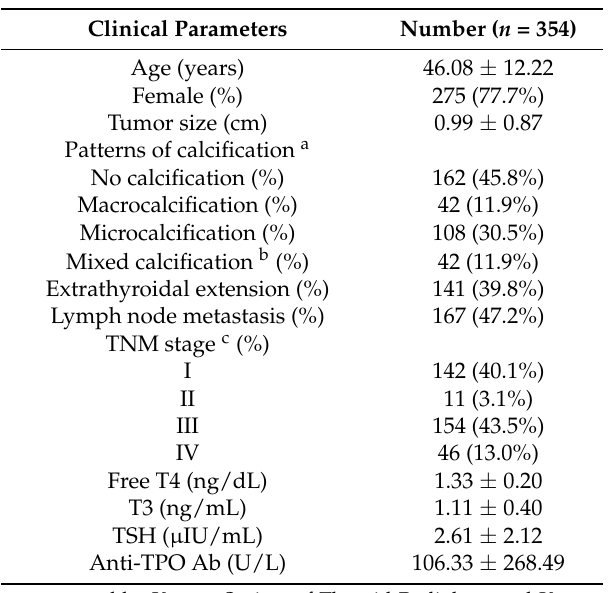
Table 2. Association of calcification pattern in PTC according to thyroid hormones (Group